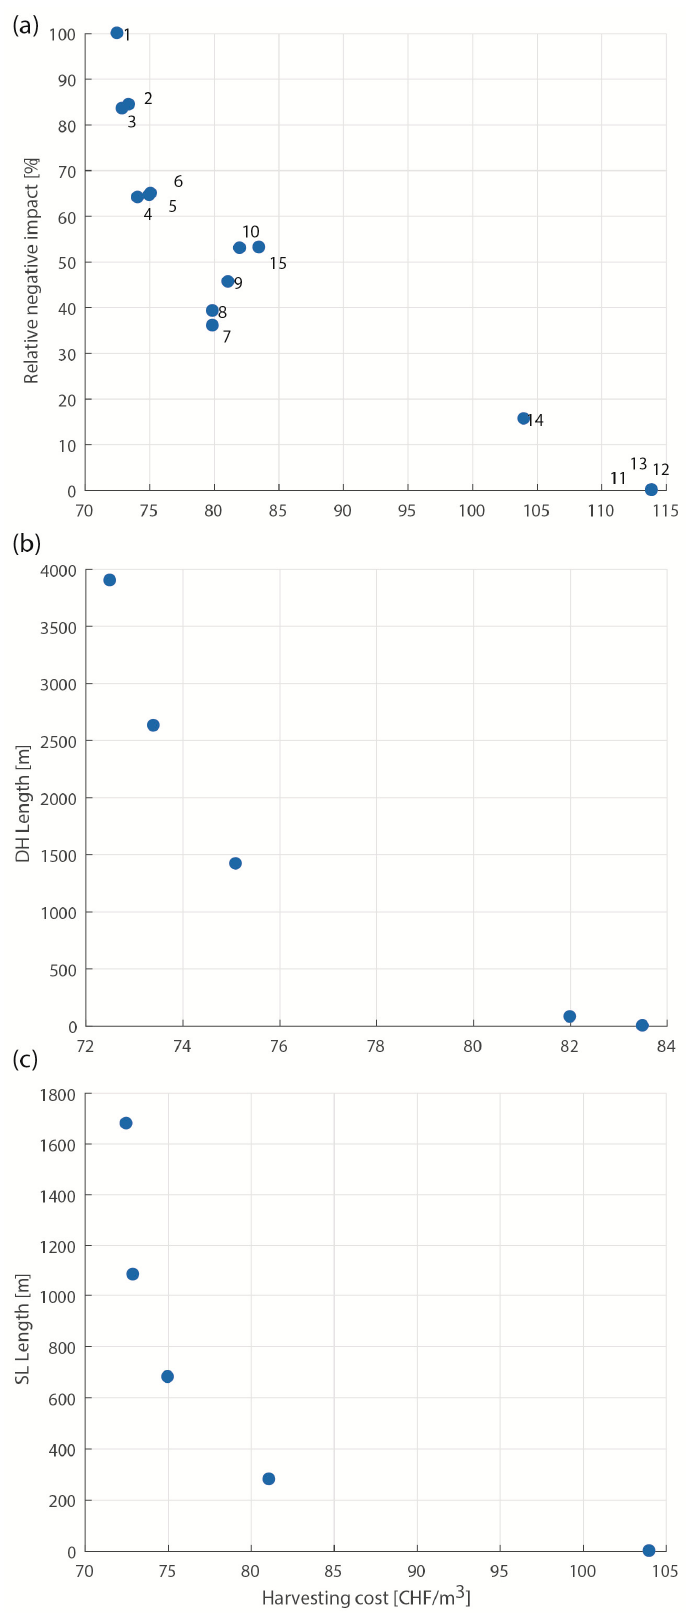
Figure 8. Pareto-optimal solutions for Rigi, Area 01, for ( a ) harvesting costs and relative negative impact ( RNI ), with case numbers displayed; ( b ) downhill logging length and harvesting costs (only cases with λ SL = 0); and ( c ) slope line length and harvesting costs (only cases with λ DH = 0).